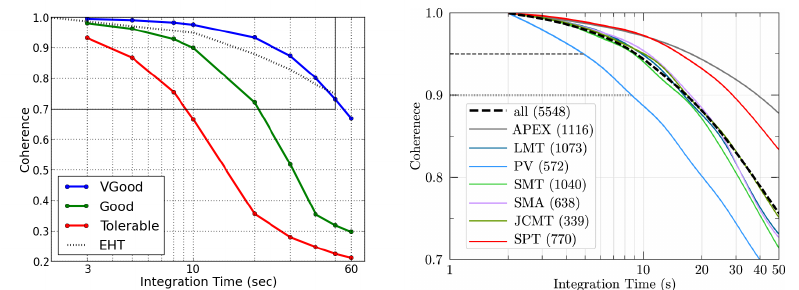
Figure 1. Comparison between atmospheric coherence measured from ARIS simulations and the empirical EHT datasets for a range of integration times up to 50 s, at 230 GHz. Plotted are first quartile values averaged over all baselines. Left : Solid lines are for the synthetic datasets under three weather conditions: Very Good (blue, C w = 0.5), Good (green, C w = 1) and Tolerable (green, C w = 2). The black dotted line is for empirical EHT observations. The simulations for Very Good weather conditions (i.e., typical ALMA conditions) reproduce well the empirical measurements. Right : Figure 2 from Event Horizon Telescope Collaboration et al. [17] shows EHT empirical measurements. Solid lines are for individual baselines to ALMA and the dotted line is the baseline averaged coherence; the latter is overplotted in left. The axis limits are shown on the left as light black